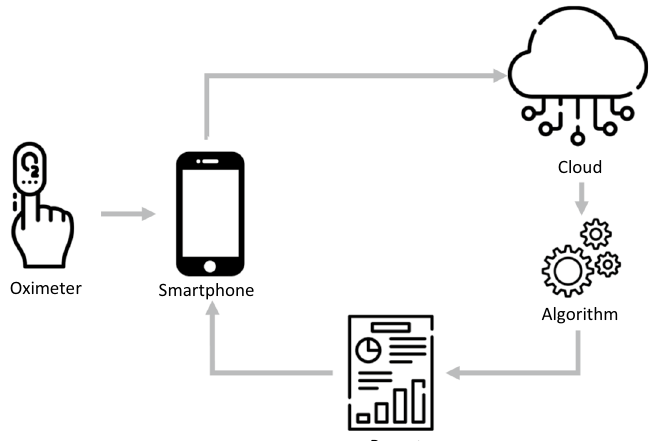
Figure 1. Image descripting the Biologix system. The wireless oximeter connects via Bluetooth to the smartphone Biologix app. An algorithm automatically analyzes the data and the send report to the patient